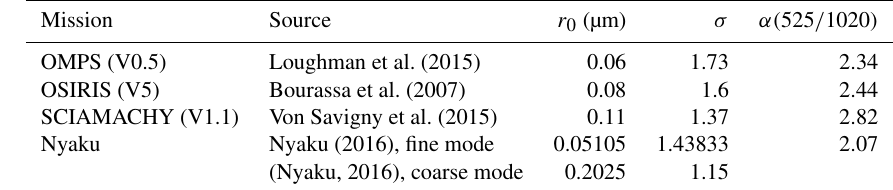
Table 2. Aerosol size distributions assumed in several recent LS aerosol extinction retrieval algorithms.